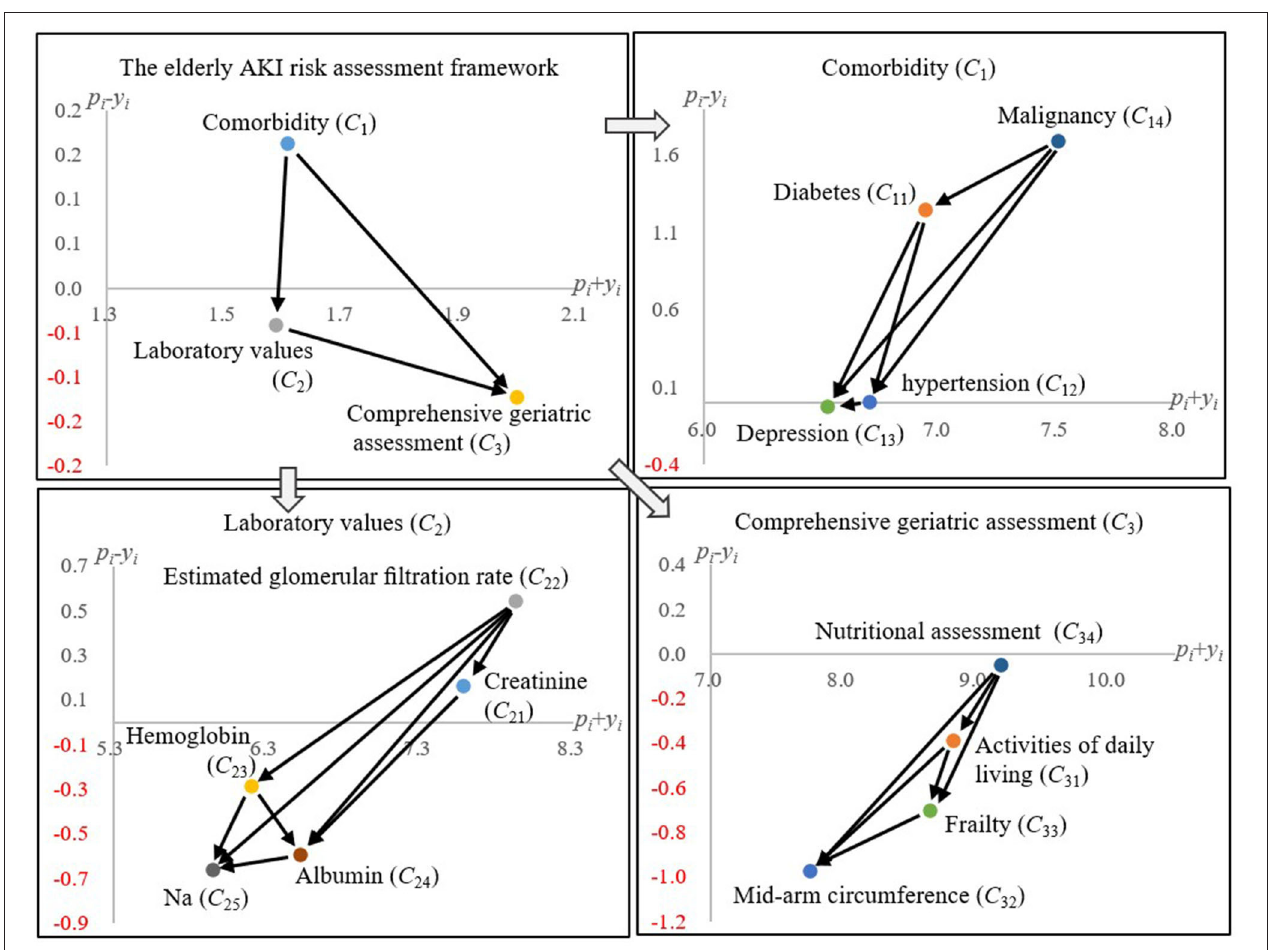
FIGURE 2 | The influential network-relation